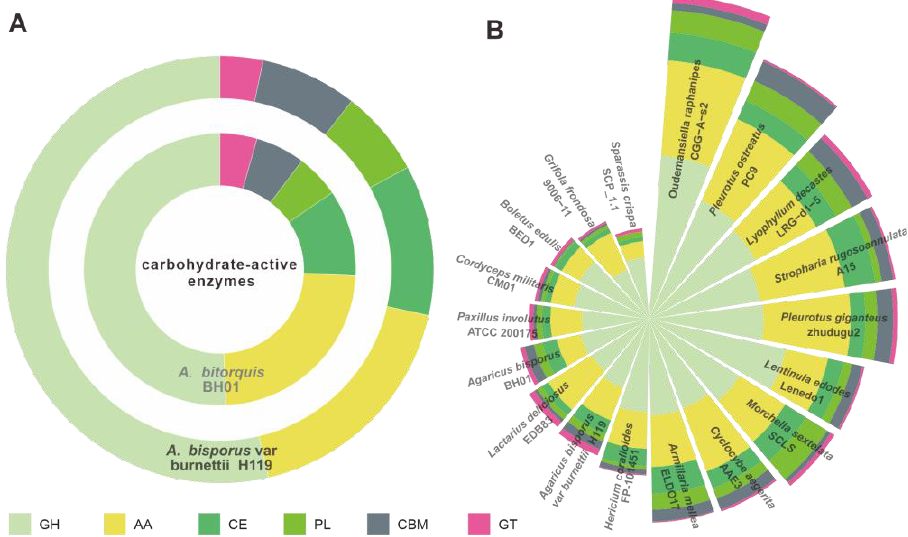
Figure 4. CAZymes analysis of Agaricus and related edible mushrooms. ( A ) Composition compari- son of CAZymes between A. bitorquis BH01 and A. bisporus var. burnettii H119. ( B ) Composition comparison of CAZymes between Agaricus species and related edible mushrooms.